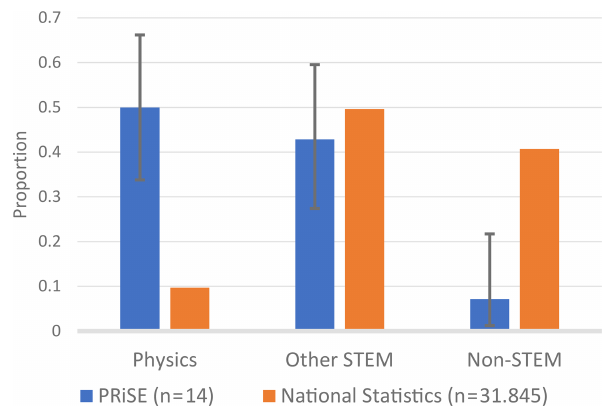
Figure 4. Degree destinations of PRiSE students (blue) compared to UK national statistics of A-Level physics students (orange). Error bars denote the standard (1 σ ) Clopper and Pearson (1934)